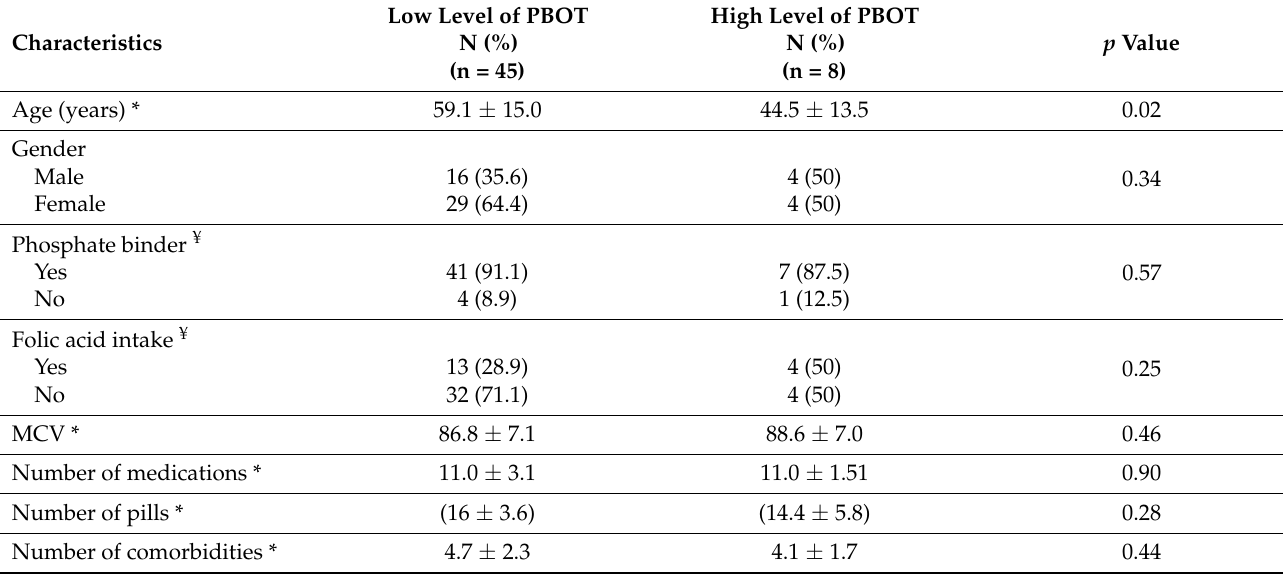
Table 3. Association between the level of Perceived Burden of Therapy (PBOT) and patient